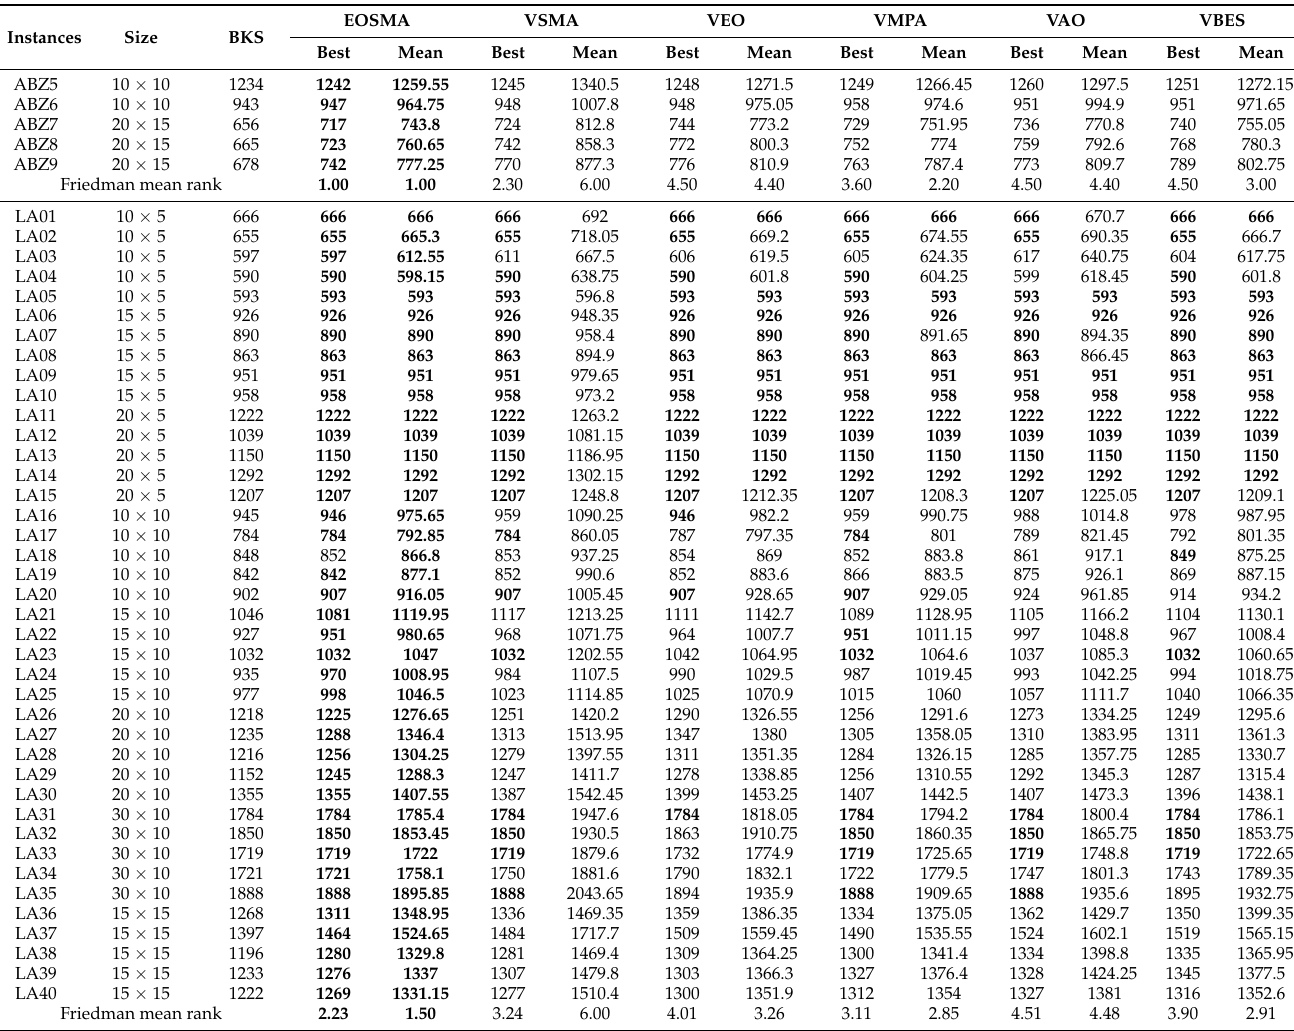
Table 6. Comparison of solution results of algorithms on ABZ and